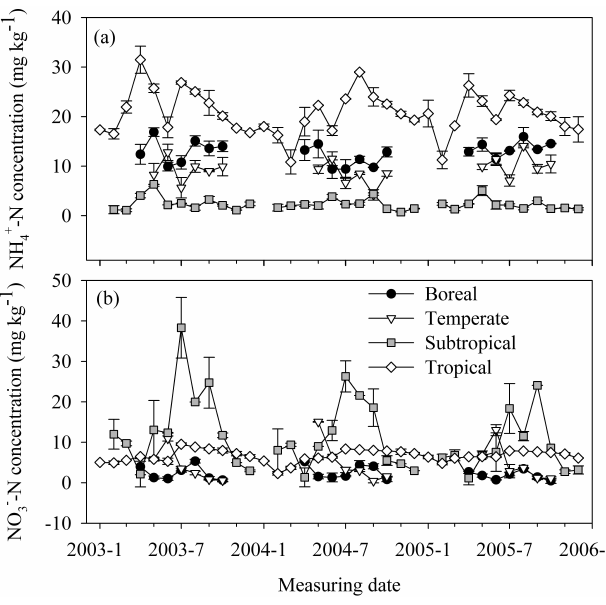
Fig. 3. The seasonal variation of soil NH + trations ( ± 1SE) at a depth of 10cm in the four forests from 2003 to